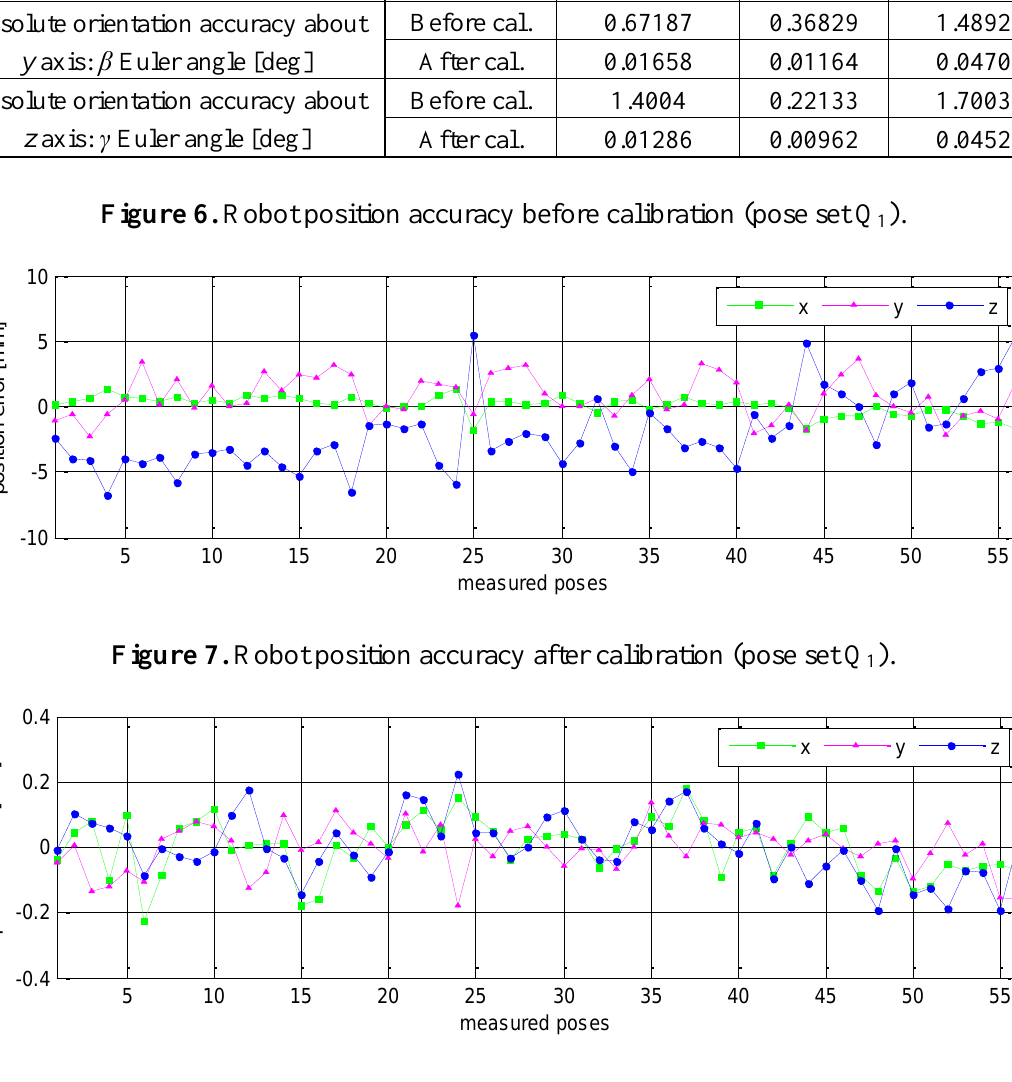
Figure 8. Robot’s absolute position accuracy before and after calibration (pose set Q